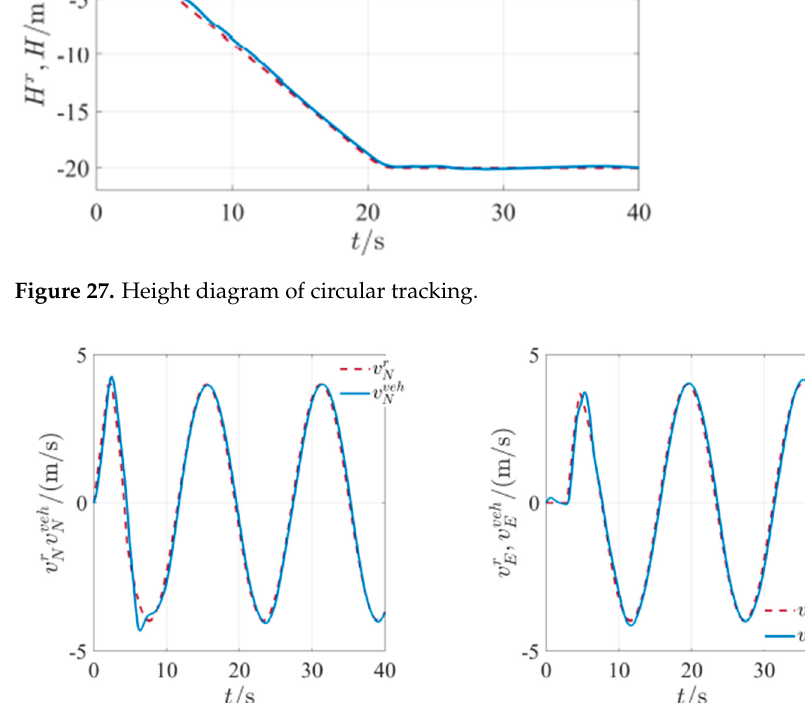
Figure 28. Horizontal velocity diagram of circular tracking.